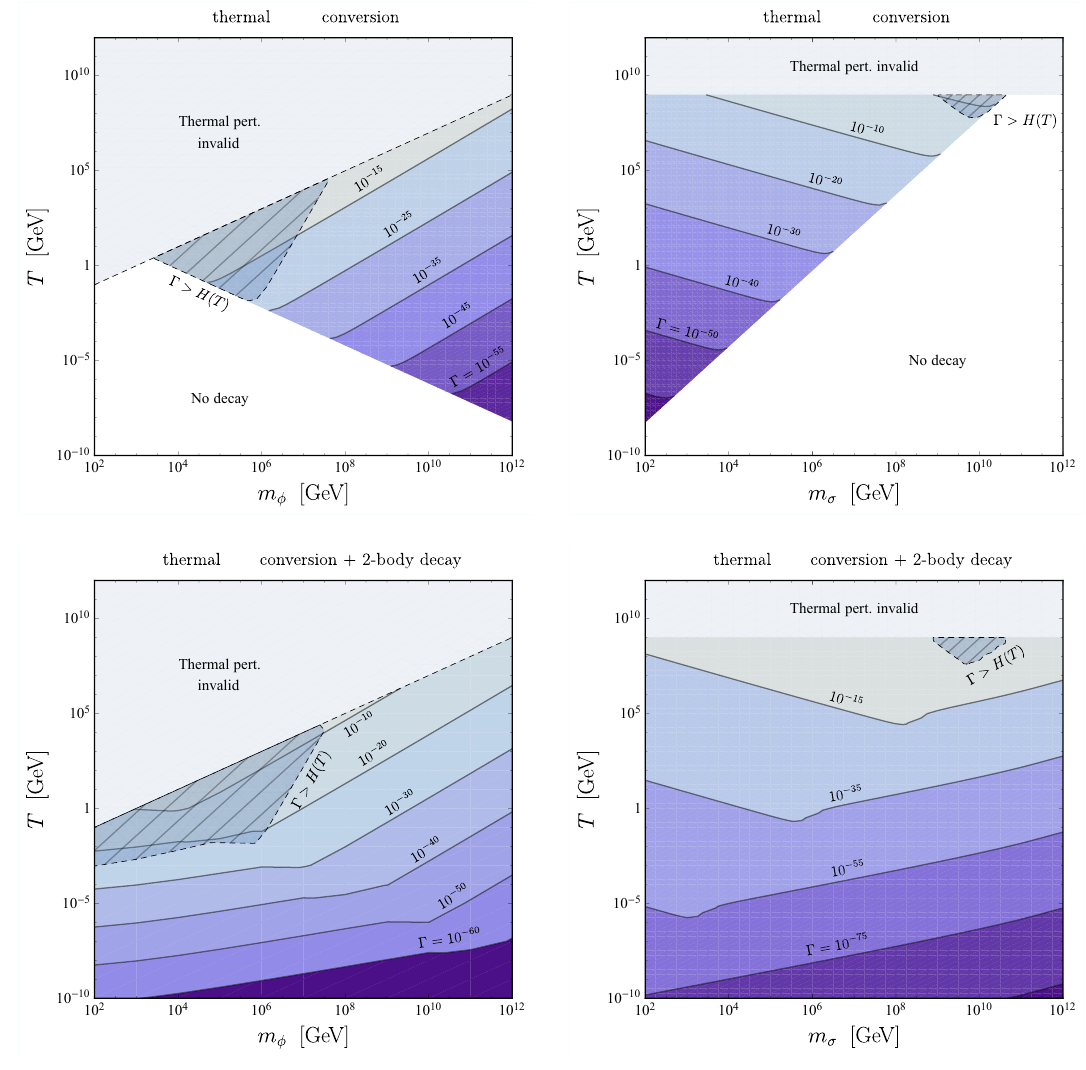
Figure 13 . The decay width caused by the thermal curve in the ( m φ , T ) -plane ( m σ = 10 2 GeV ) and in the ( m ) -plane ( m = 10 12 GeV ). The top (bottom) two panels correspond to the conversion σ , T φ process (the conversion and two-body decay processes). The values around the contours are given in GeV unit. In the white blank regions, the conversion process is kinematically forbidden. The gray regions with “Thermal pert. invalid” is excluded since the condition T < 10 − 3 m